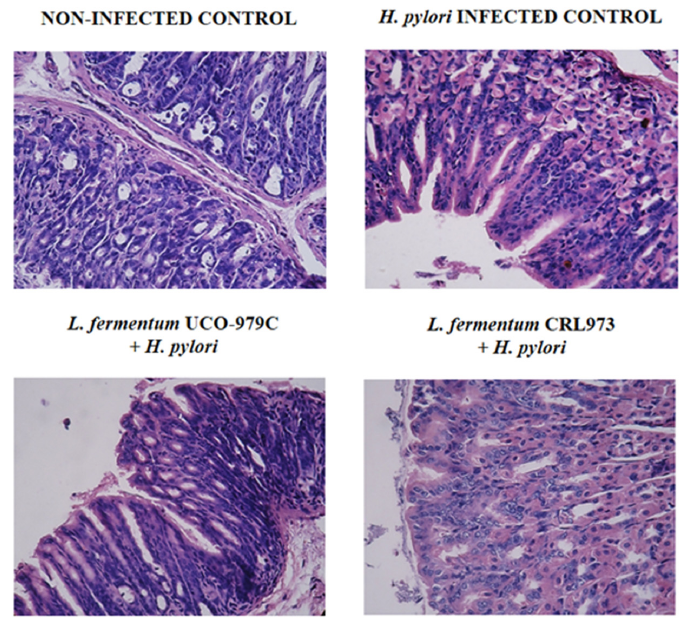
Figure 2. Effect of viable L. fermentum UCO-979C or L. fermentum CRL973 in the gastric inflammatory response of competent adult mice infected with H. pylori SS1. L. fermentum UCO-979C or L. fermentum CRL973 were administered to different groups of mice for two consecutive days at a dose of 10 8 CFU/mouse/day, then mice were challenged with H. pylori SS1. Two days post-infection, mice were euthanized, and histopathological evaluation of gastric samples was performed. Hematoxilin/eosin stained sections of gastric mucosa. Upper left: Normal appearance of mice gastric mucosa. Upper right: Control group: Swiss mice infected with H. pylori . Lower left: L. fermentum UCO-979- H. pylori group. Lower right: L. fermentum CRL 973- H. pylori group. Original magnification 200×. 3.2. L. fermentum UCO-979C Differentially Modulates the Immune Response Against H. pylori Infection in Mice Cytokines and chemokines were measured in the stomach (Figure 3) and serum (Figure 4) samples of lactobacilli-treated and untreated control groups after the challenge with H. pylori . The infection of adult immunocompetent mice with H. pylori significantly increased the levels of the inflammatory factors IFN- γ , TNF- α , MCP-1 and IL-8, as well as the levels of the regulatory cytokine IL-10 when compared to basal levels in non-infected animals (data not shown). Mice treated with L. fermentum UCO-979C had significantly higher levels of gastric and serum IFN- γ when compared to the control group (Figure 3,4). On the contrary, the UCO-979C-treated group showed significantly lower levels of gastric and serum TNF- α and IL-8 compared to the control group (Figure 3,4). L. fermentum UCO-979C was also able to reduce the levels of MCP-1 in the gastric mucosa when compared to controls (Figure 3). In addition to its ability to diminish inflammatory cytokines and chemokines, it was observed that the UCO-979C strain was capable of inducing a significant increase in IL-10 levels when compared to controls in both the gastric mucosa (Figure 3) and serum (Figure 4). The group of animals treated with L. fermentum CRL973 did not exhibit any variation in gastric IFN- γ , IL-10, TNF- α , MCP-1 levels and only gastric IL-8 values were lower than that observed in the control group (Figure 3). On serum samples, there were not statistically significant differences between L. fermentum CRL973 and control mice (Figure 4).